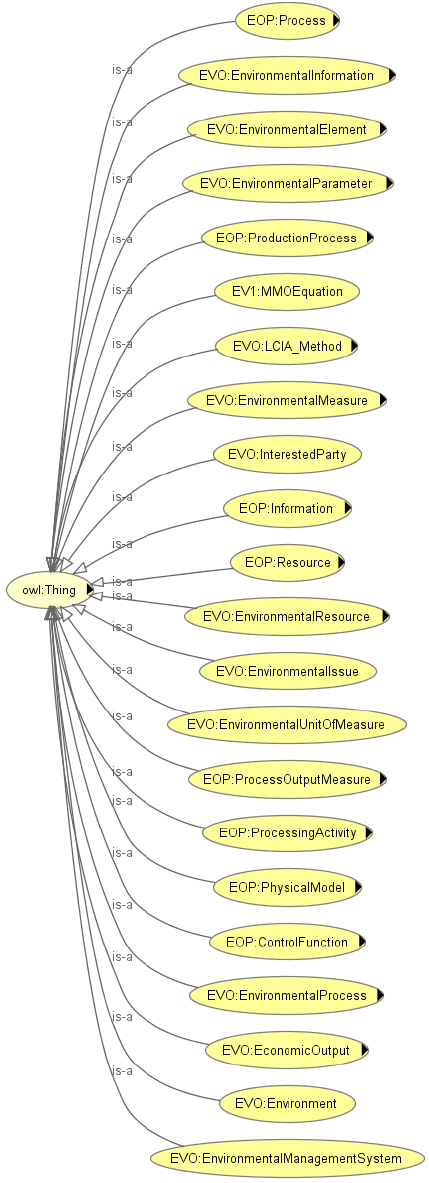
Figure 9. First taxonomical representation of the Enterprise Ontology Project